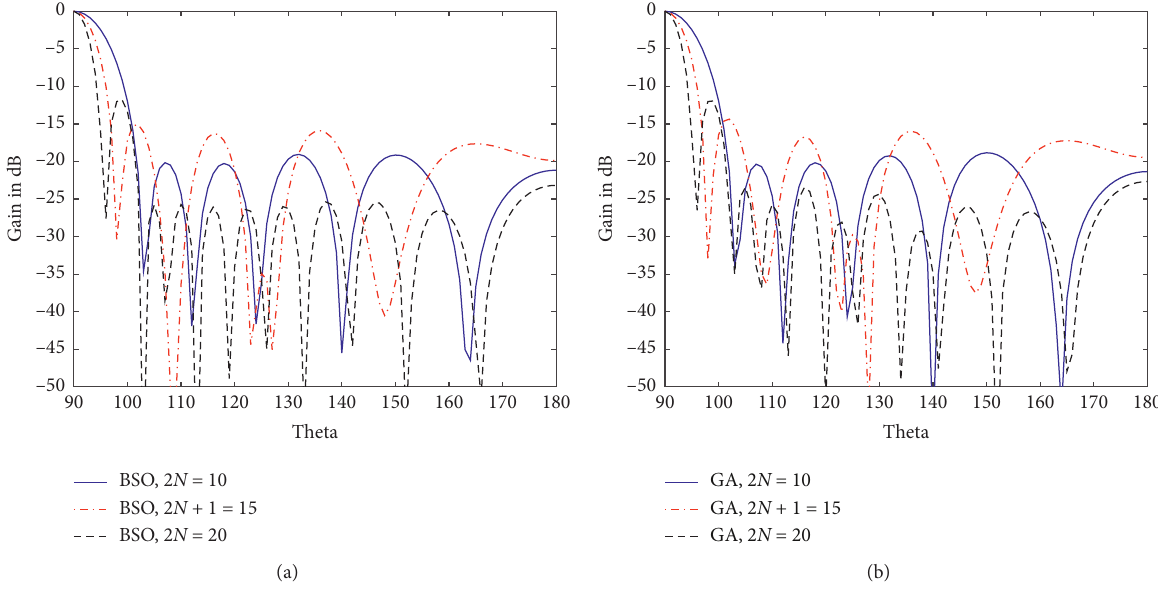
–0.96–0.958–0.956–0.954–0.952–0.95–0.948–0.946–0.944–0.942 50 100 150 200 250 300 350 400 450